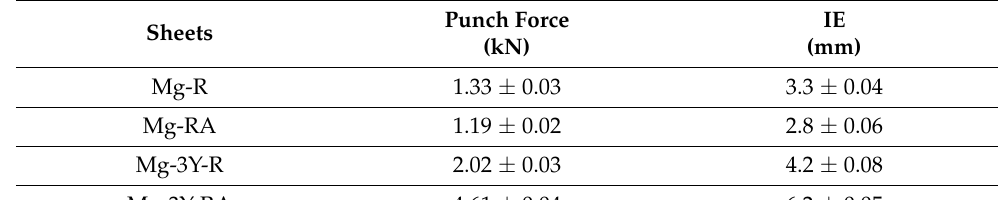
Table 5. Stretch formability of the sheets at room temperature. Sheets